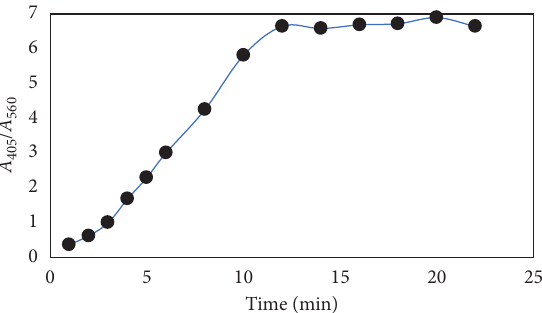
Figure 7: Reaction time of the colorimetric sensor for 5.0 × 10 − 4